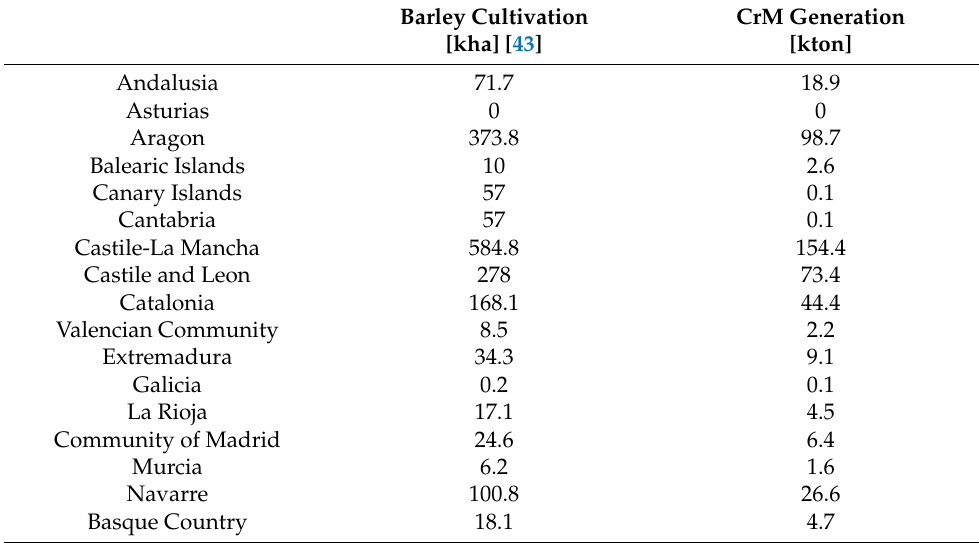
Table 6. Estimation of CrM waste generation based on data from cultivated barley hectares from [43]. Barley